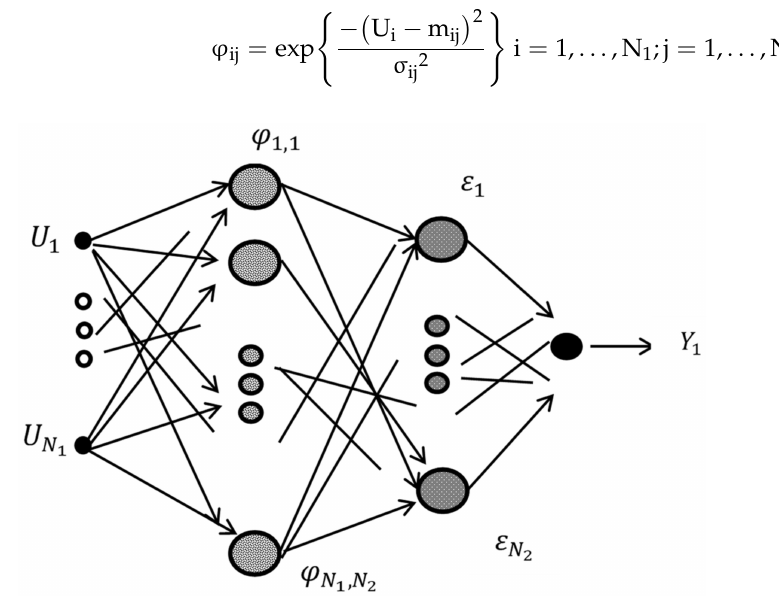
Figure 4. Structure of the GNF